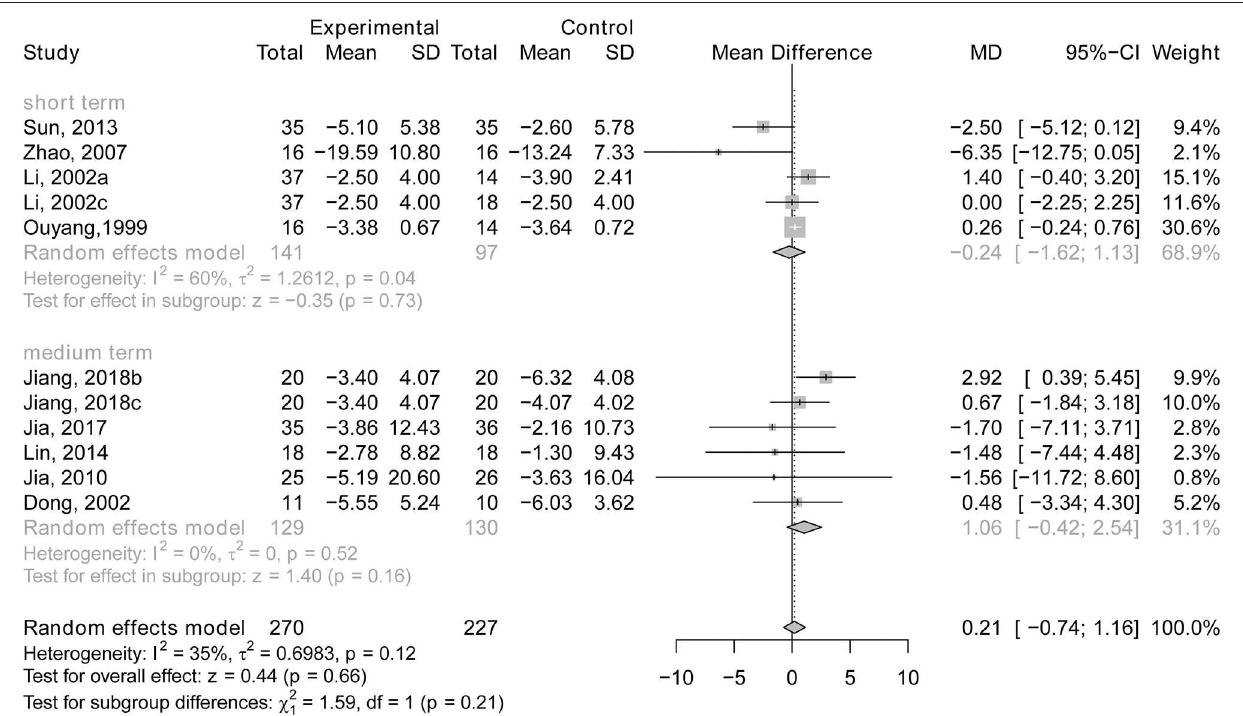
FIGURE 11 | The forest plot of ADL of acupuncture vs. drug therapy. Li (2002a), acupuncture vs. Nimodipine; Li (2002c), acupuncture vs. Dangguishaoyaosan; Jiang (2018b), acupuncture vs. Donepezil hydrochloride; Jiang (2018c), acupuncture vs. Jiannaosan.